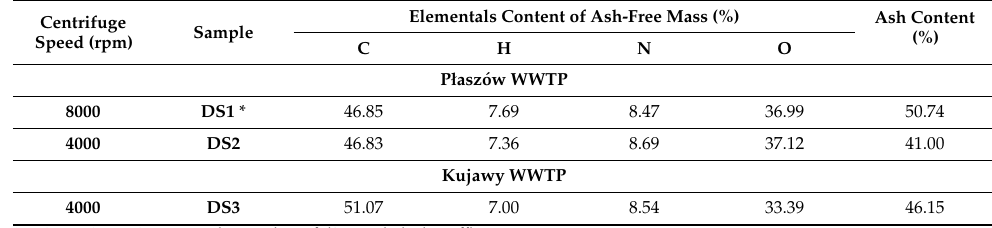
Table 5. Elemental composition for digested